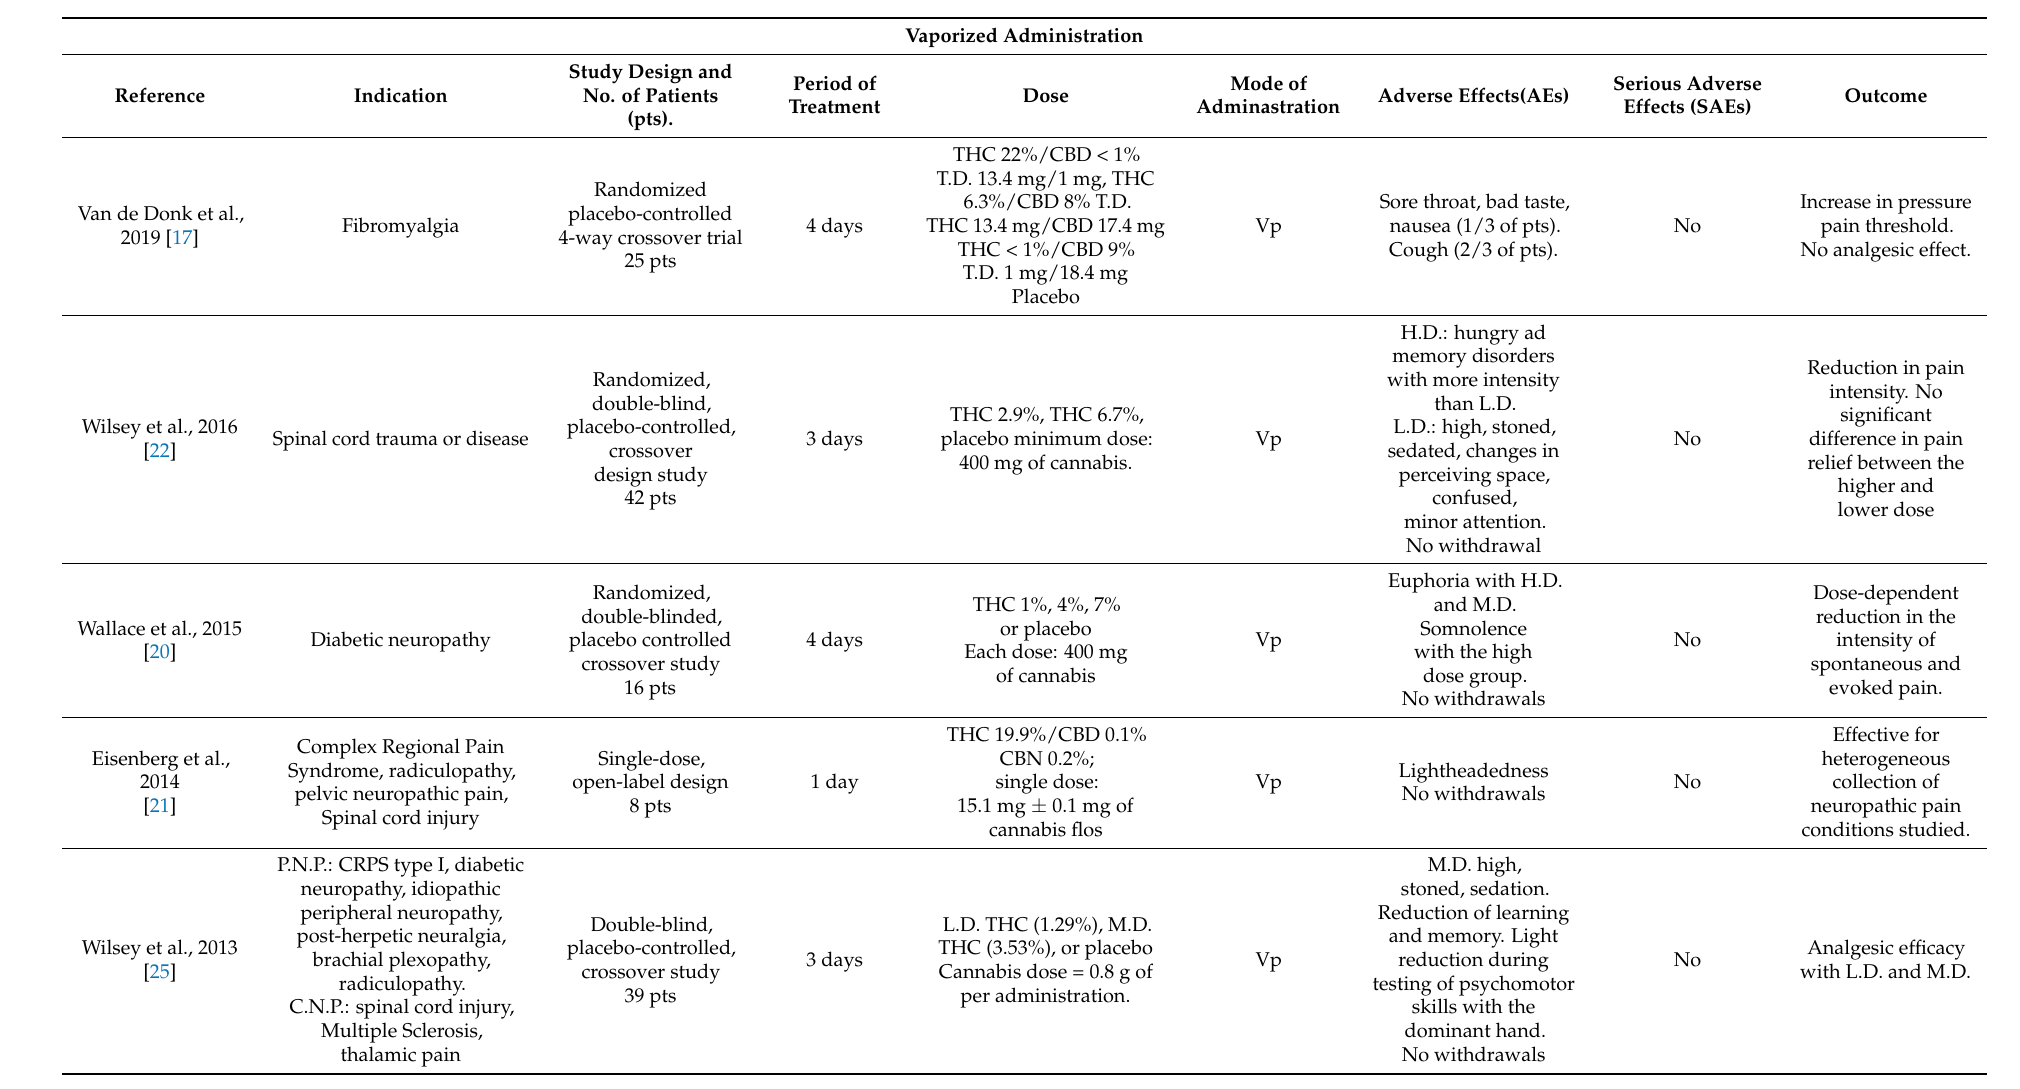
Table 2. Principal characteristics of clinical studies reporting the use of Cannabis for neuropathic